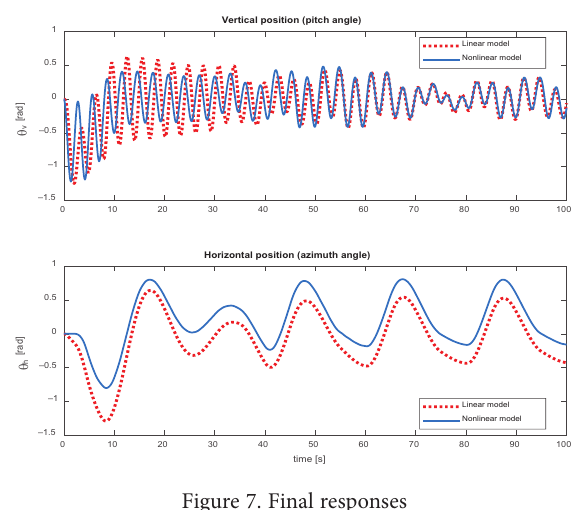
Figure 7. Final responses